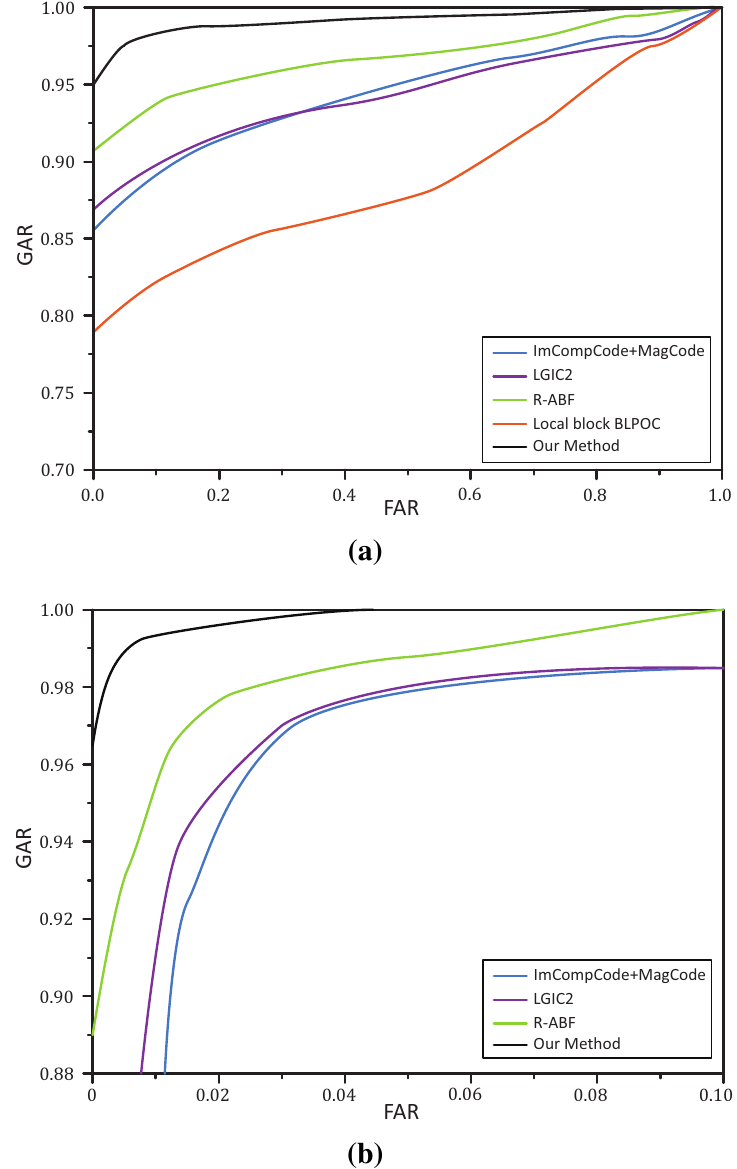
Figure 12. The ROC curves of all methods based on DB-2. ( a ) Single ROI recognition; ( b ) Integrated ROI